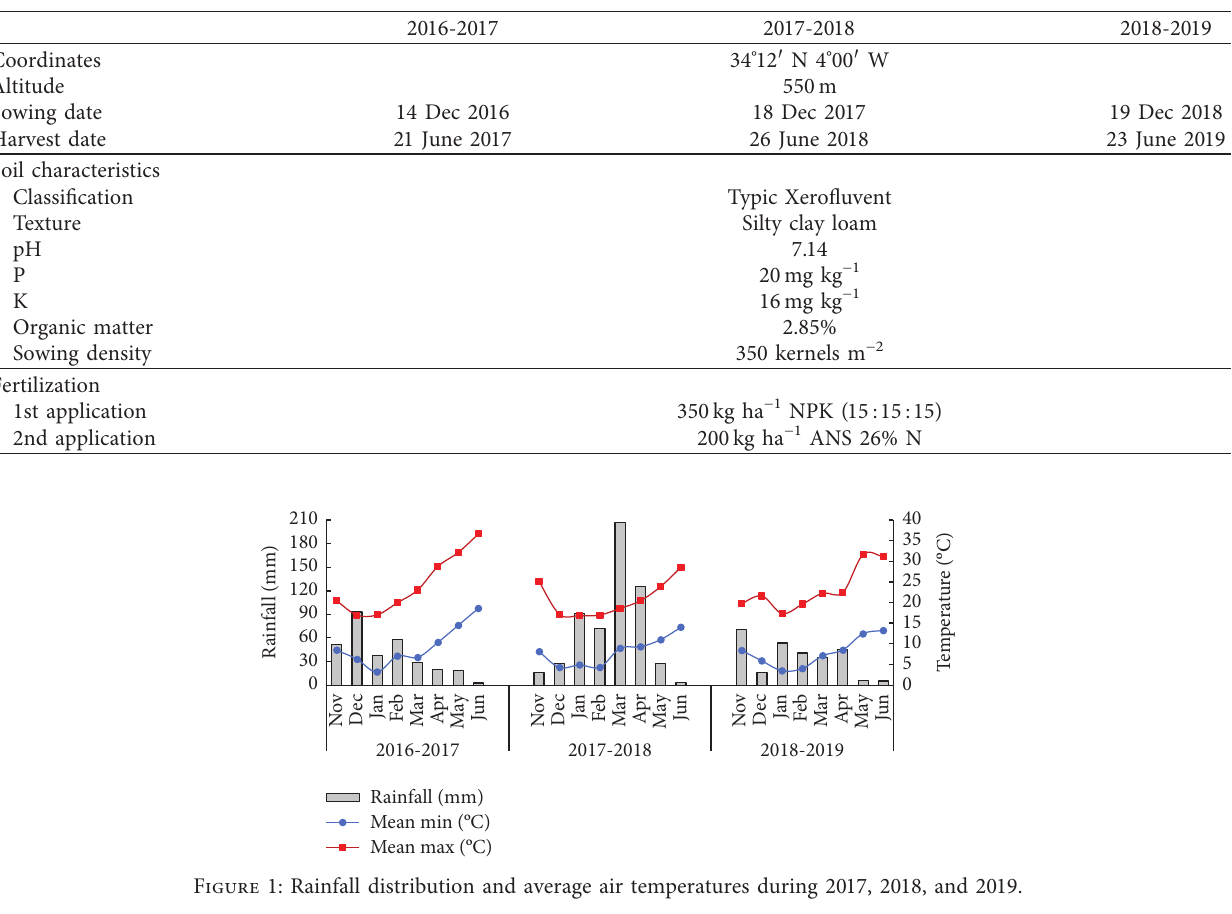
Table 1: Experimental conditions of the